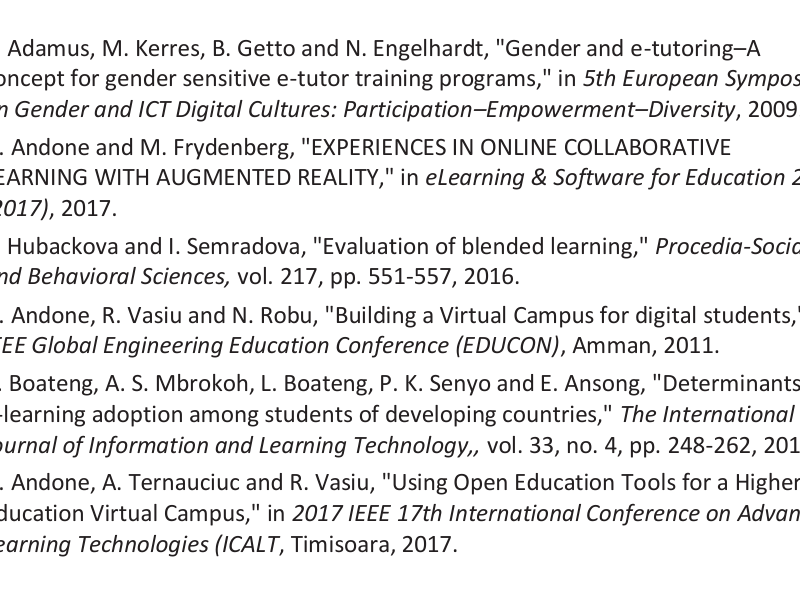
Fig. 6: Forum Posts by